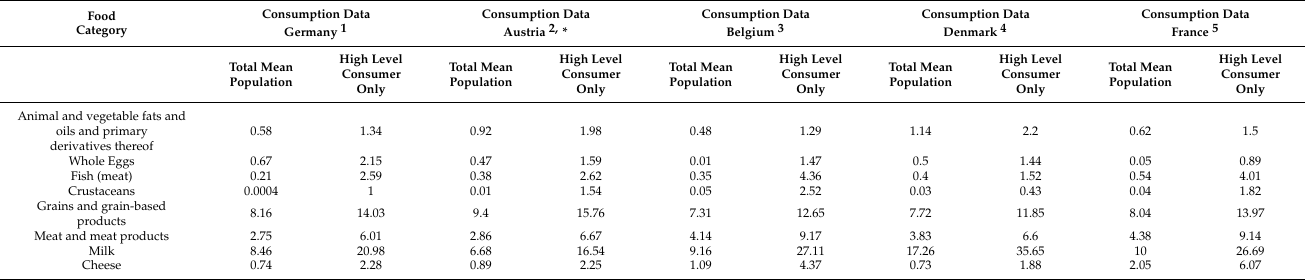
Table 2. Food consumption data presented by country and food groups [g/kg bw/d] (EFSA,